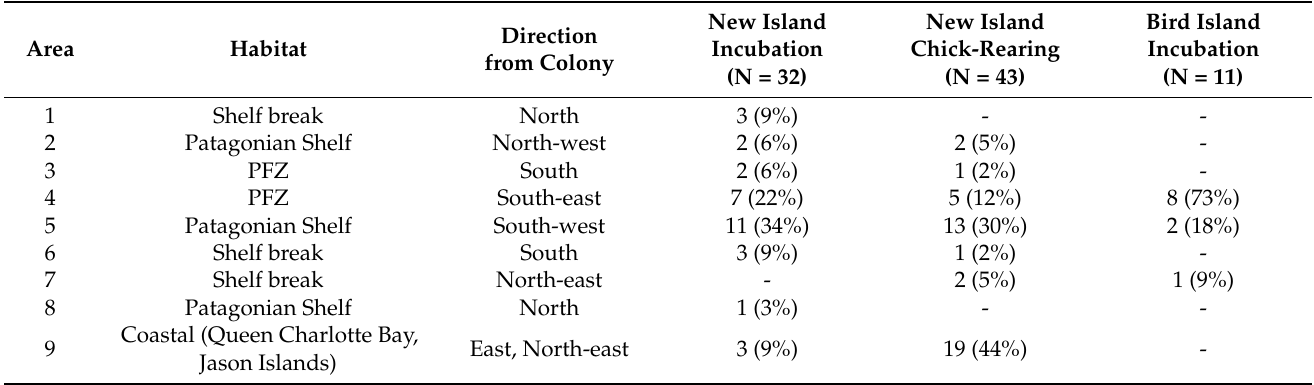
Table 3. Foraging areas of GPS-tracked Thin-billed Prions. Area numbers refer to Figure 1. PFZ = Polar Frontal